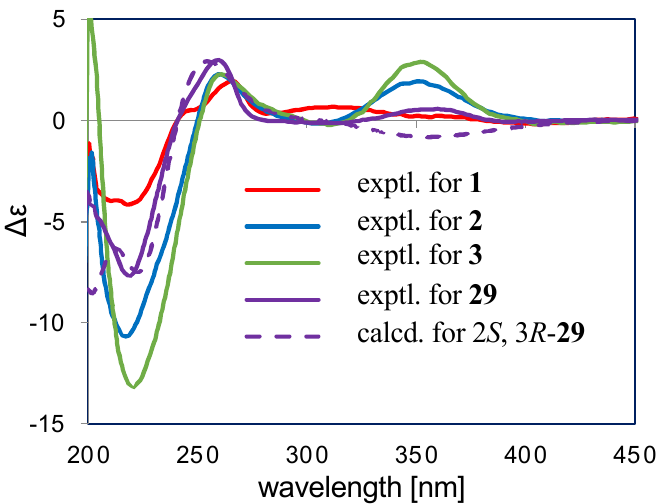
retical ECD spectrum of (2 S ,3 R )- 29 . Therefore, the absolute configurations of 1 – 3 were tively. The calculated ECD spectra of (2 R ,3 R )- 29 and each optimized conformer of (2 S ,3 R )- 29 are shown in Supplementary Materials: Figures S19 and S20.